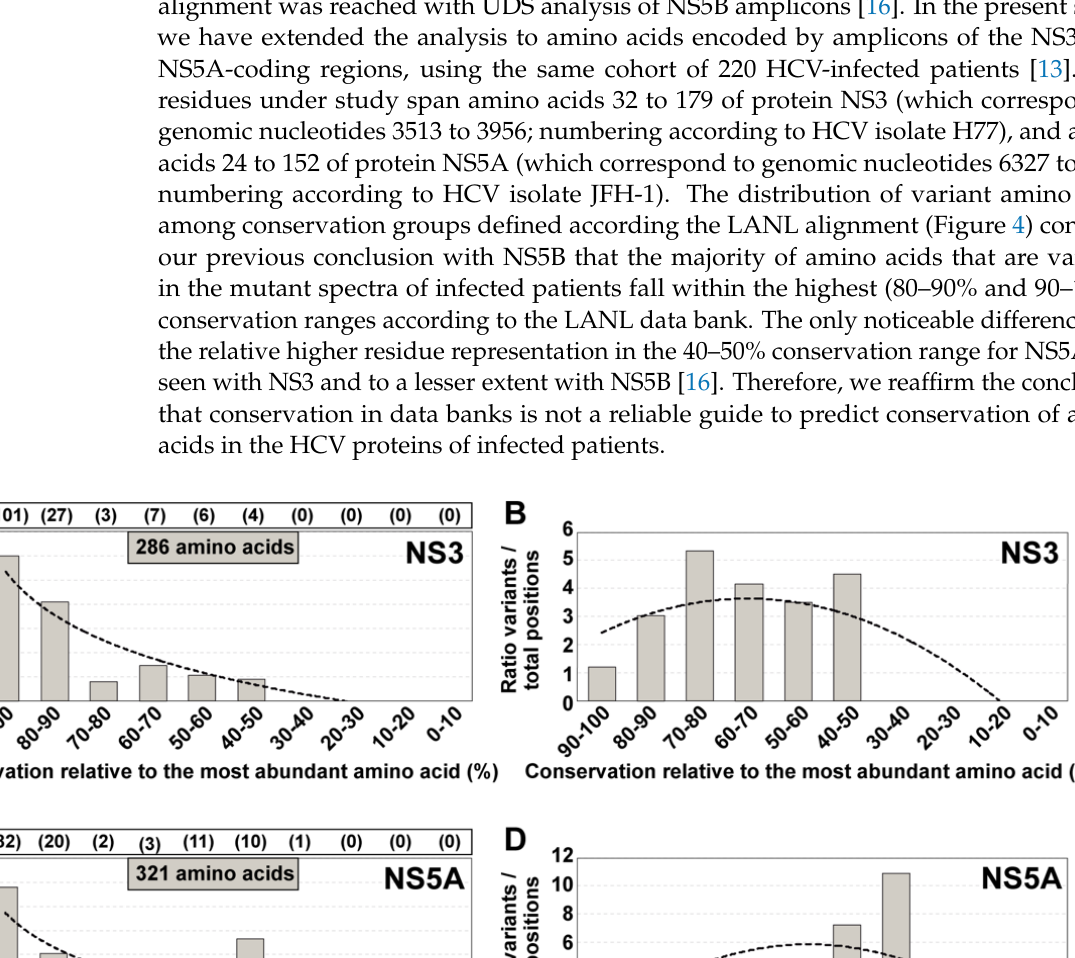
the LANL alignment, or whether the two conservation scores were unrelated. The results (Figure 5) show that the great majority of amino acids that were conserved among the different mutant spectra fell into the 90–100% LANL conservation group, and none below the 80–90% conservation group. This new calculation underlines the advantage of